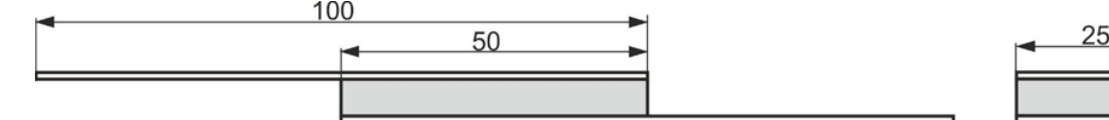
Figure 14. Sample for core strength testing. Figure 14.